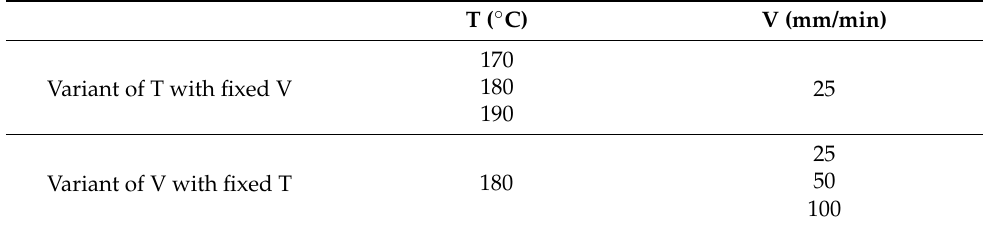
Figure 8. Experimental set-up for thermal bias-extension test. Table 2. Thermo-condition variants for the extension